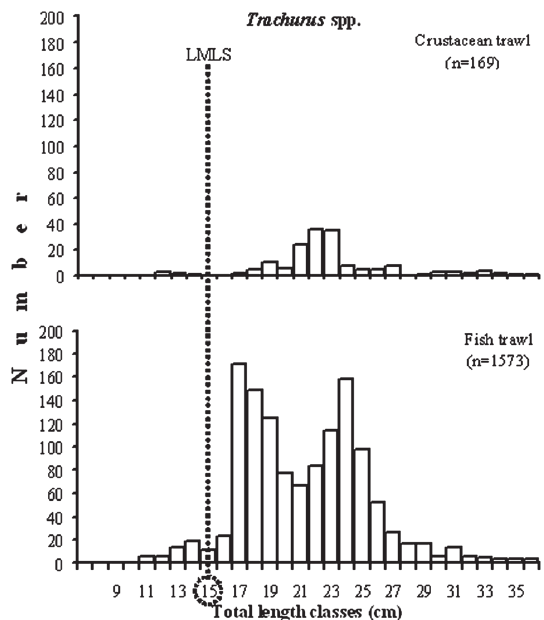
Fig . 7. – length frequency distribution of the fish trawl target spe- cies Trachurus spp. (Horse mackerel) (lMls=legal Minimum landing size).